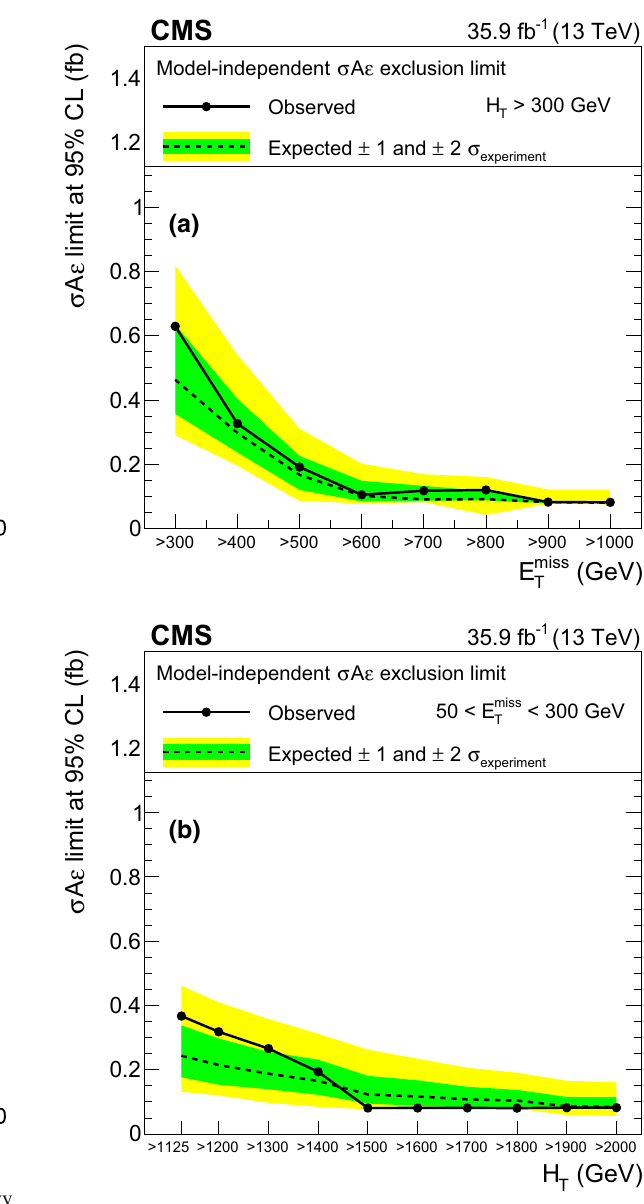
Fig. 9 Limits on the product of cross section, detector acceptance, and selection efficiency, σ A (cid:8) , for the production of an SS dilepton pair as a function of the E miss ( a ) and of H T ( b ) thresholds T kinematic tails, as well as results from a smaller number of inclusive and exclusive signal regions.